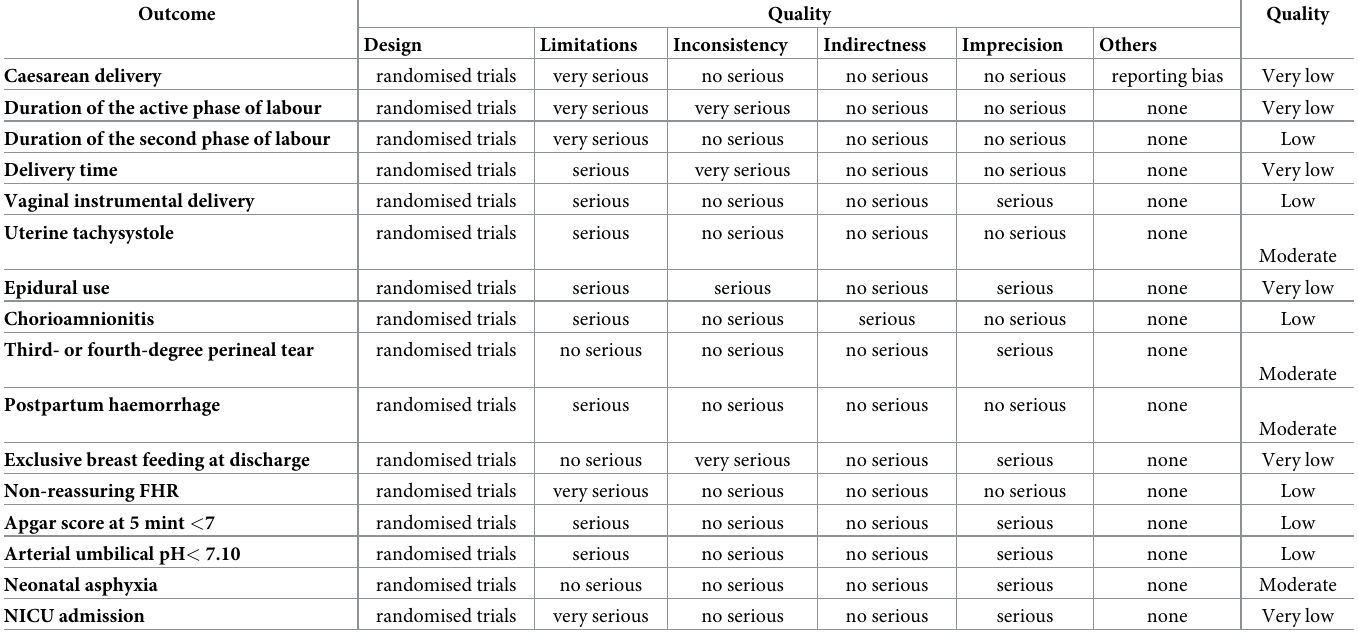
Table 4. Details for GRADE